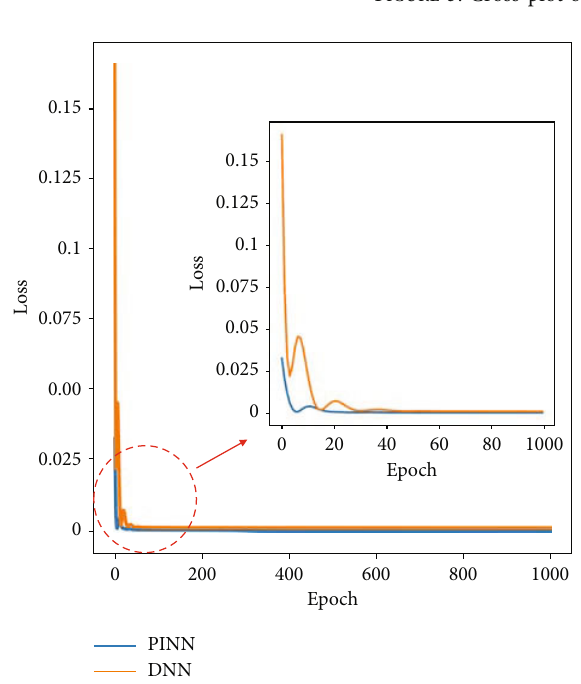
Figure 5: Cross-plot of the DNN and PINN models.